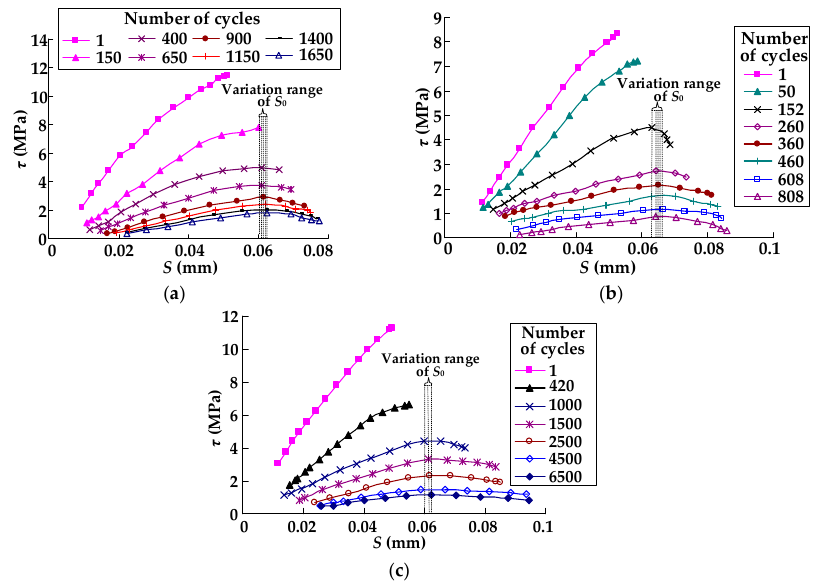
Figure 4. Bond–slip curves at different load cycles for specimens: ( a ) C-1; ( b ) C-2; and ( c ) D-1.